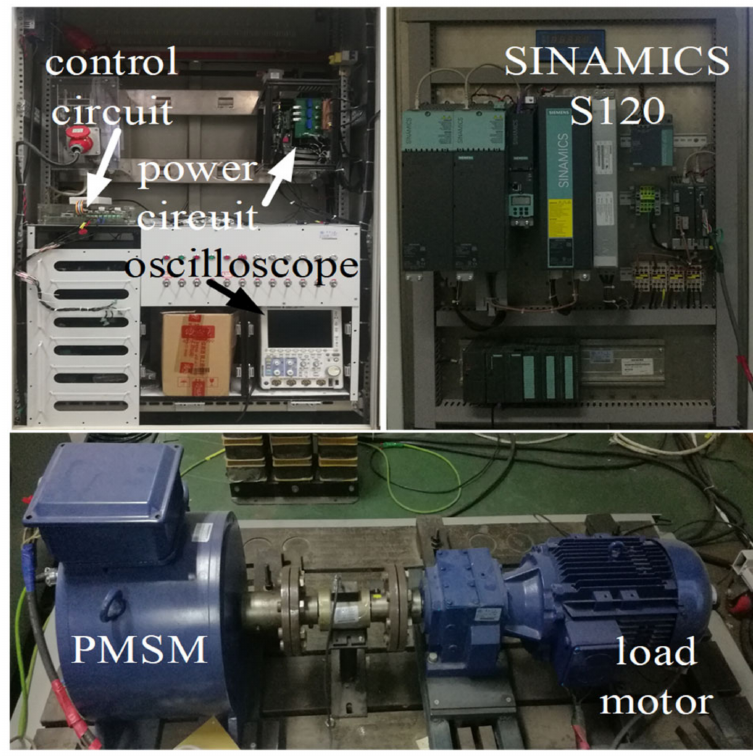
Figure 8. Experimental platform.